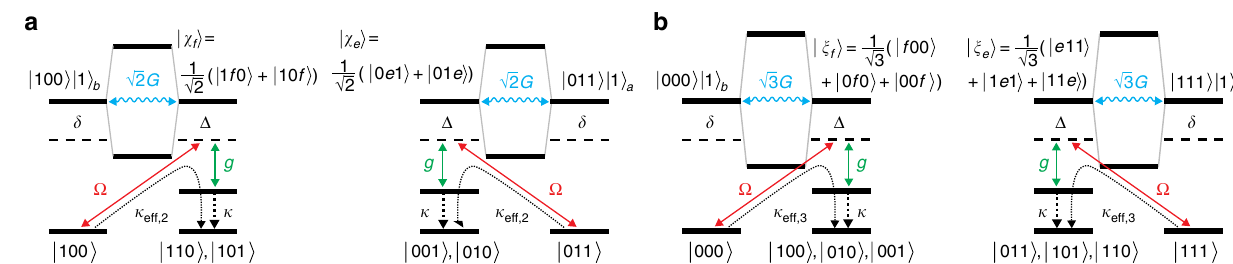
(cid:1) (cid:3) (cid:1) ¼ ffiffiffi p 3 G . These states are